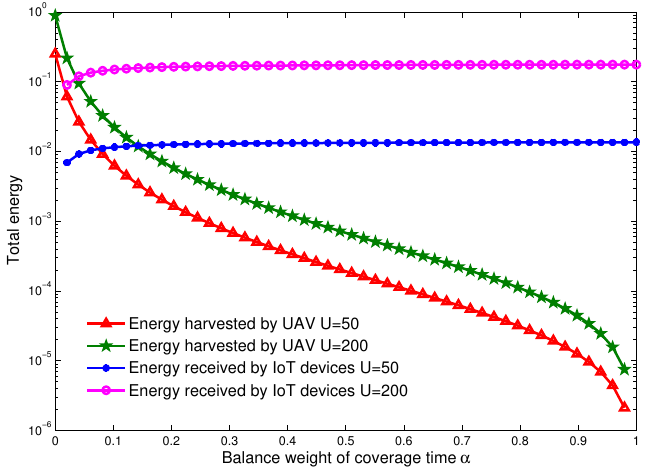
Figure 7. Total energy harvested by UAV and received by IoT